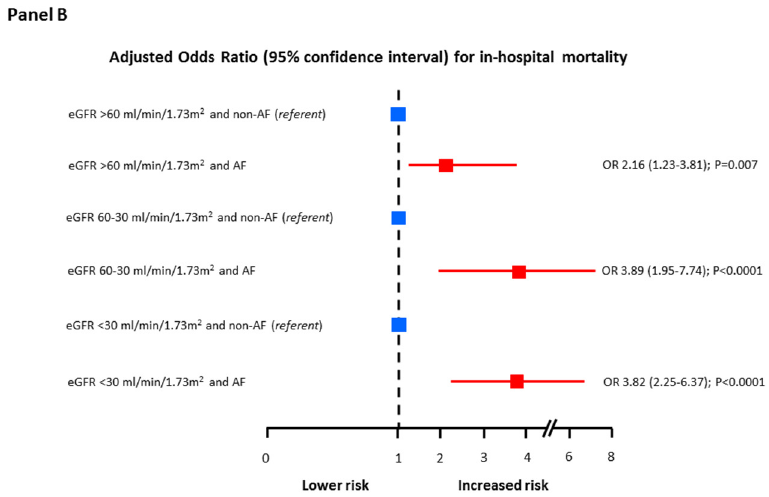
Figure 3. ( Panel A ) In-hospital mortality rate in the three study groups according to AF (yes vs. no). ( Panel B ) Adjusted odds ratio (OR) and 95% confidence intervals for in-hospital mortality according to AF in each study group. Odds ratios were adjusted for independent predictors of in-hospital mortality, identified by logistic regression analysis with stepwise selection of variables (age, acute myocardial infarction type, left ventricular ejection fraction, Killip class, and admission glycemia) in the entire study population.